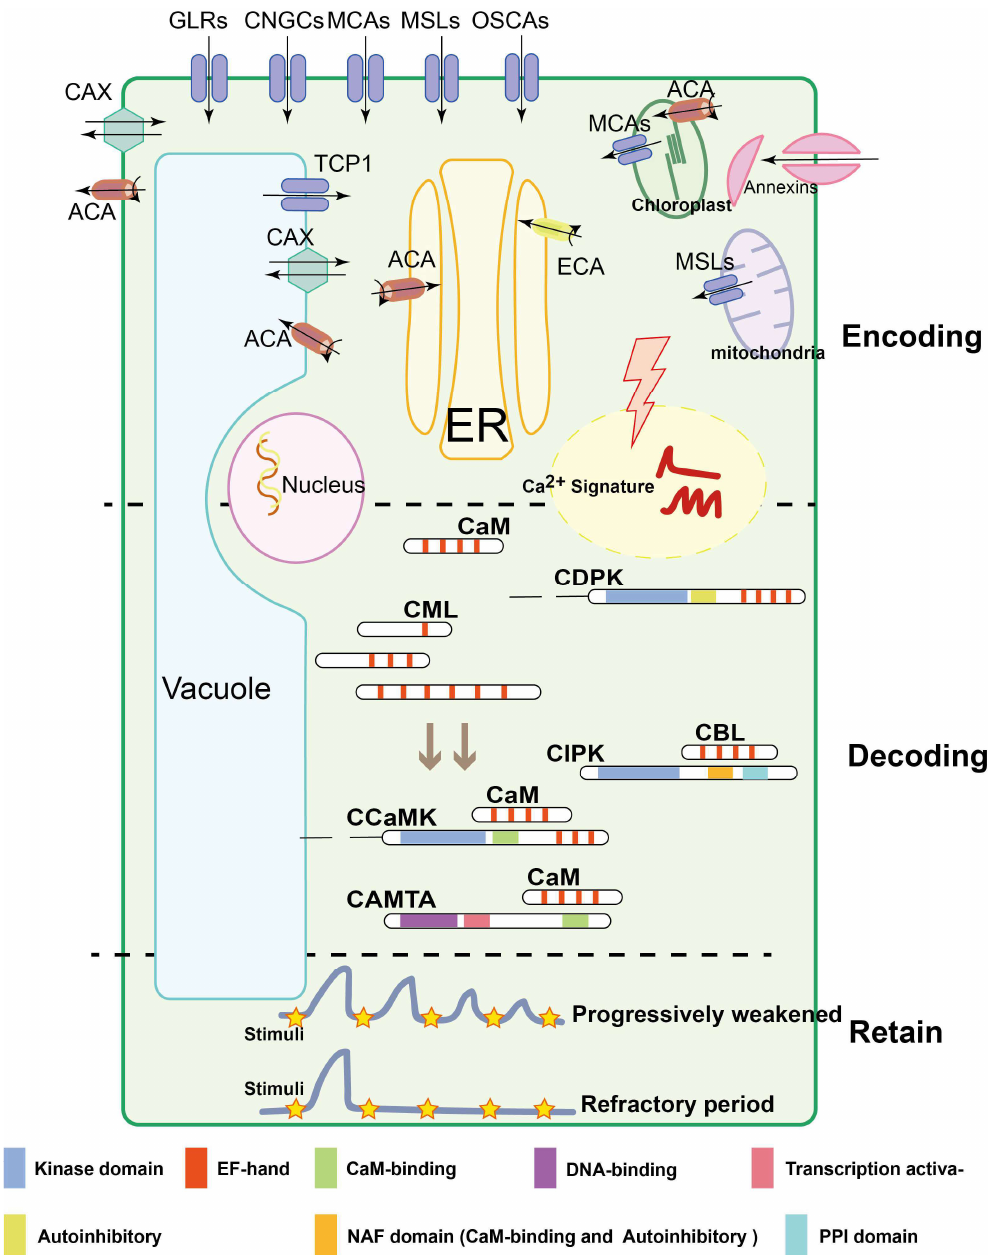
Figure 1. Three major processes implicated in Ca 2+ signal stimulus-induced dynamic alterations: encoding, decoding and retaining. Ca 2+ encoding is mediated by Ca 2+ channels, Ca 2+ -ATPases, Ca 2+ /H + exchangers, channels named CNGCs, GLRs, TPCs, MCAs, MSLs, OSCA1, ATPases named ACAs, ECAs, and the antiporter named CAX; besides this, annexins without EF-hand domains are also involved in Ca 2+ influx. The decoding is composed of many different protein families. CaMs, CMLs and CBLs harbor EF hand domains and regulate target proteins without any additional functional domains. CBLs modulate the activity of CIPKs interacting with NAF and PPI domain, while CDPKs are directly activated by Ca 2+ binding to the CaM-like domain. In contrast to CDPKs, CCaMKs are dual-regulated kinases. These proteins bind Ca 2+ via a visinin-like domain, while in addition, Ca 2+ -CaM binds to the regulatory domain of the kinase and mediates further activation. CAMTAs activate the transcription of related genes by interacting with CaM. Ca 2+ signatures retain a steady-state concentration under the same stimulation for a short period through persistent decaying or during a refractory period. Colored modules represent different functional structures. The black lines with an arrow indicate the direction of Ca 2+ flow, and the black curve with an arrow indicates the ATP decomposition reaction (ATP to